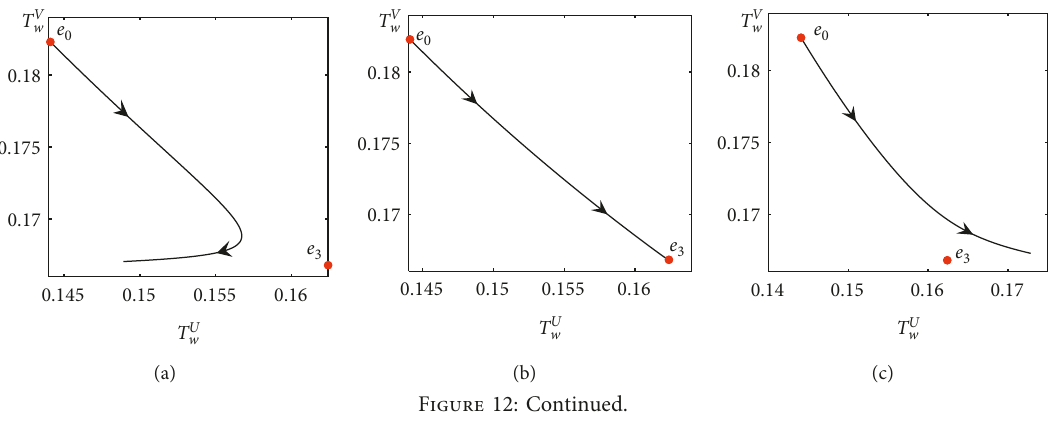
Figure 11: Equilibrium transition when T T V w